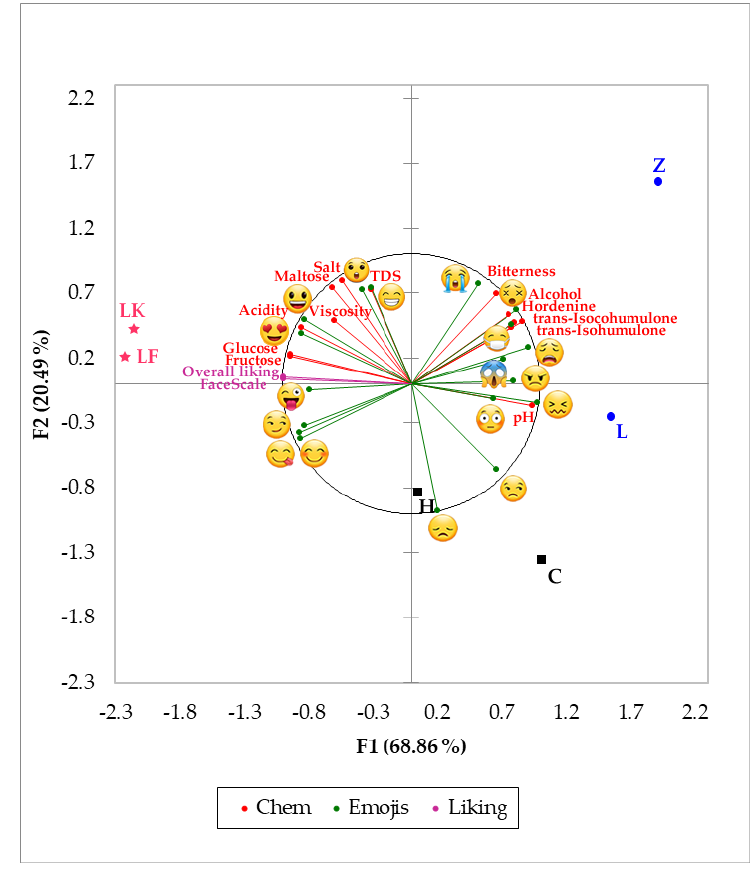
12 of 19 Figure 2. Principal components analysis showing the results from the sensory (self-reported liking responses in blue), biometrics (purple for emotions, and green for the emojis generated from the facial expressions), and chemical data (orange). Abbreviations: PC1 and PC2 = principal component 1 and 2, TDS = total dissolved solids. Abbreviations for samples are shown in Table 1. Figure 3 shows the MFA for all chemicals, liking, and check all that apply data using emojis (Figure 3a) and emotion-terms (Figure 3b). In the MFA using emojis (Figure 3a), it can be observed that factors 1 and 2 (F1 and F2) represented 89.35% of total data variability (F1 = 68.86%; F2 = 20.49%). According to FL, the F1 was mainly represented by